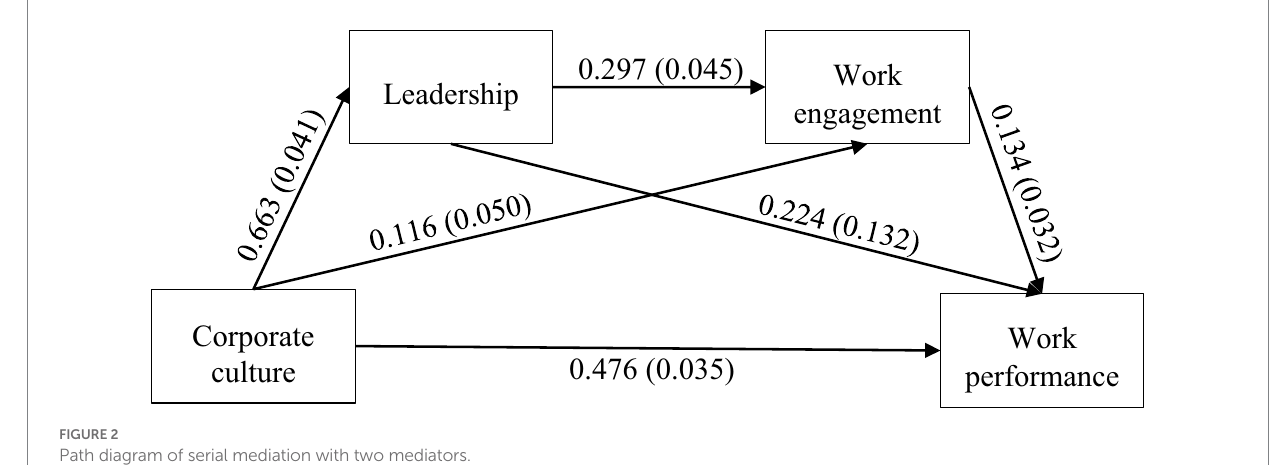
FIGURE 2 Path diagram of serial mediation with two